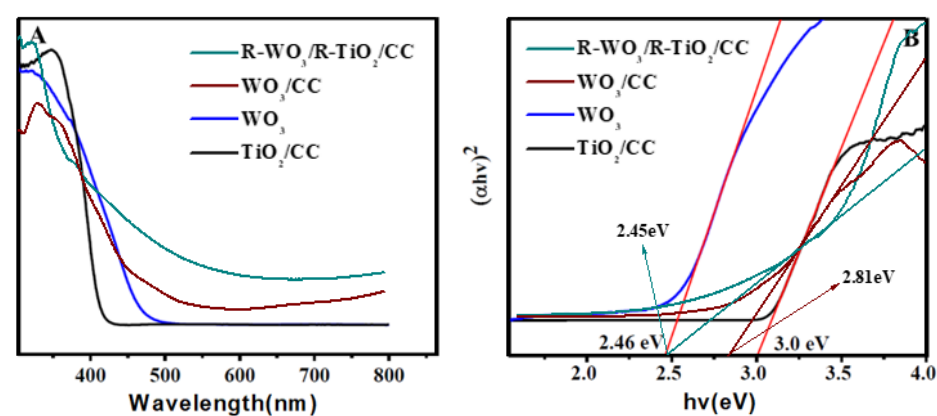
Figure 8. UV-visible DRS of TiO 2 /CC and R-WO 3 /TiO 2 /CC ( A ) and Tauc plot ( B ).